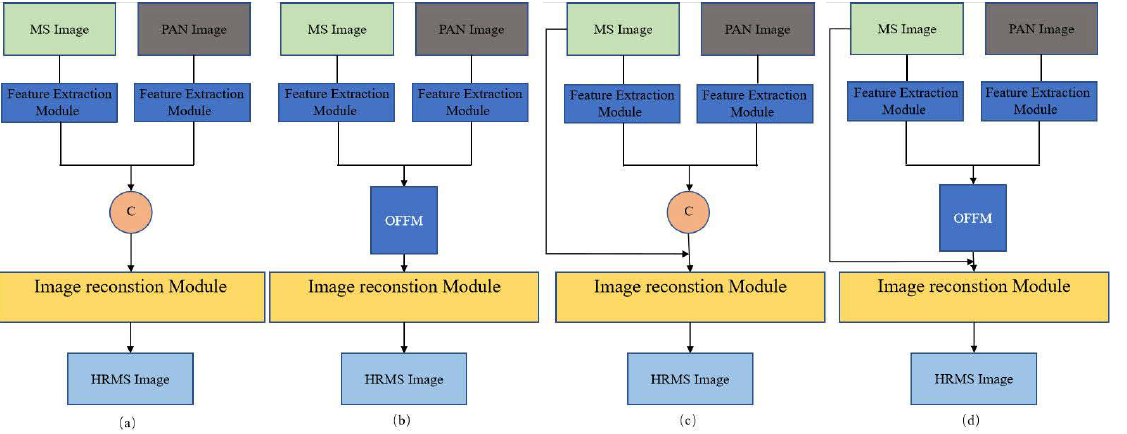
Figure 4. Ablation experiment. ( a ) Original. ( b ) Attention-original. ( c ) Skip-original. ( d ) Our- (cid:96) 2.